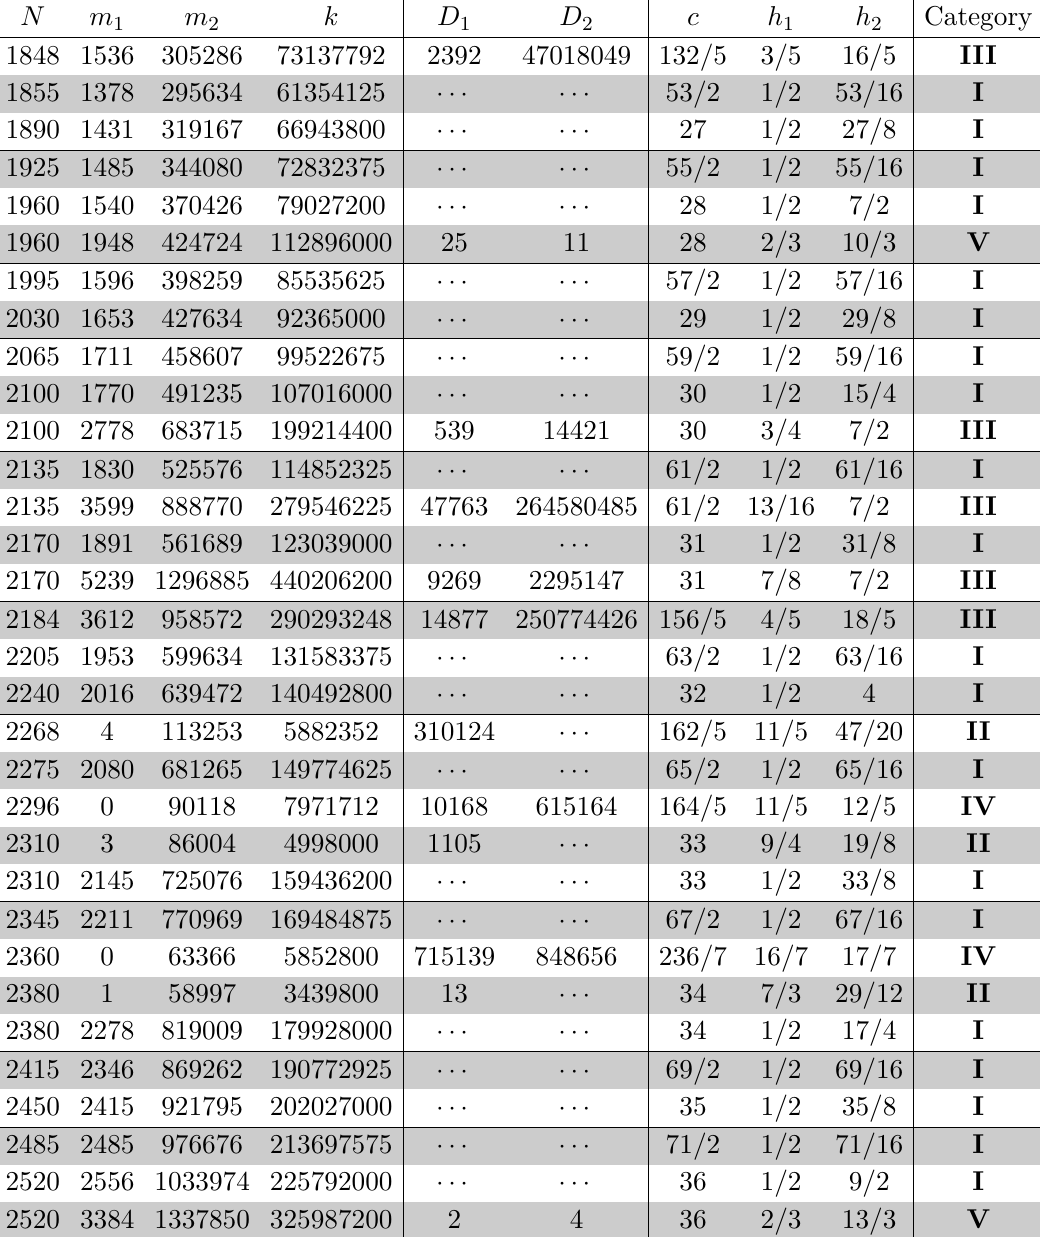
Table 16 . Solutions to the [ 3 , 0 ] MLDE with 26 < c ≤ 36